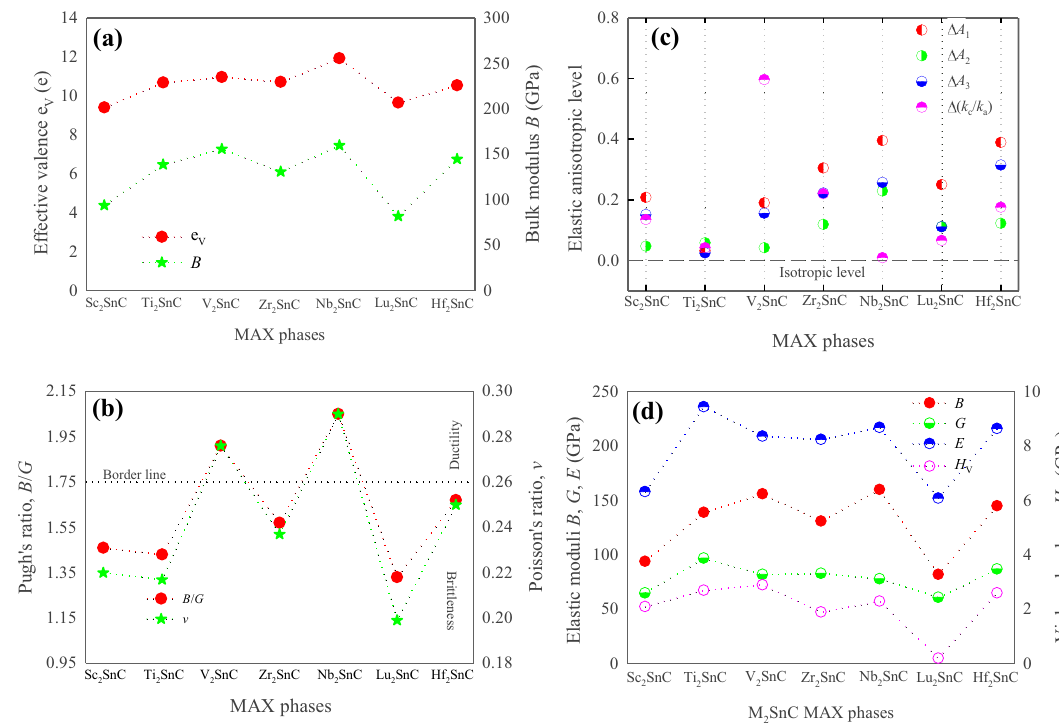
Figure 4. ( a ) Bulk modulus with effective valence; ( b ) Pugh’s and Poisson’s ratio; ( c ) elastic anisotropy level and ( d ) Vickers hardness with elastic moduli of M 2